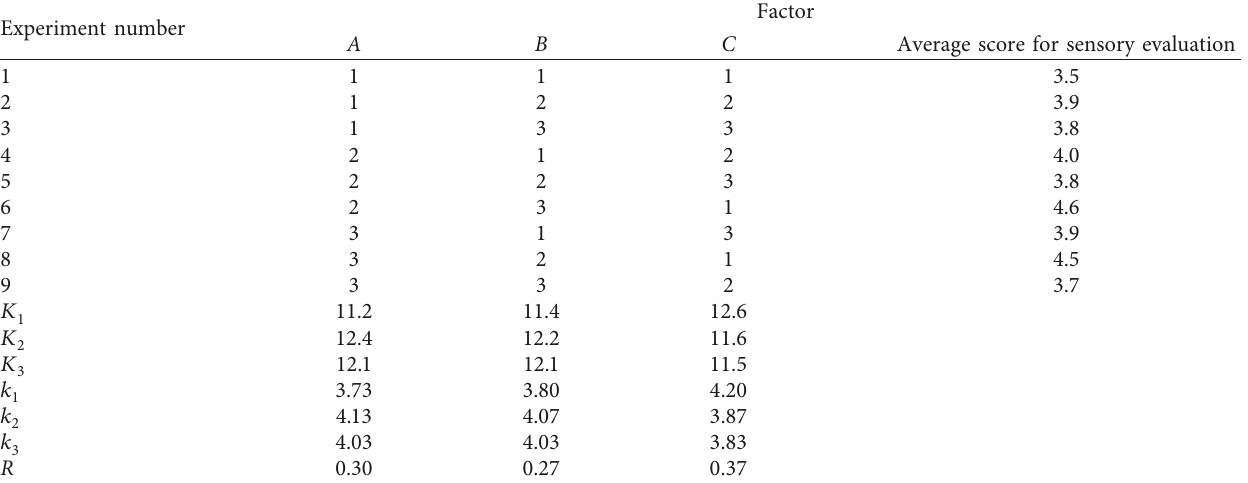
Table 10: Results of orthogonal experiments on the fermentation dosage of compound juice in scheme I.